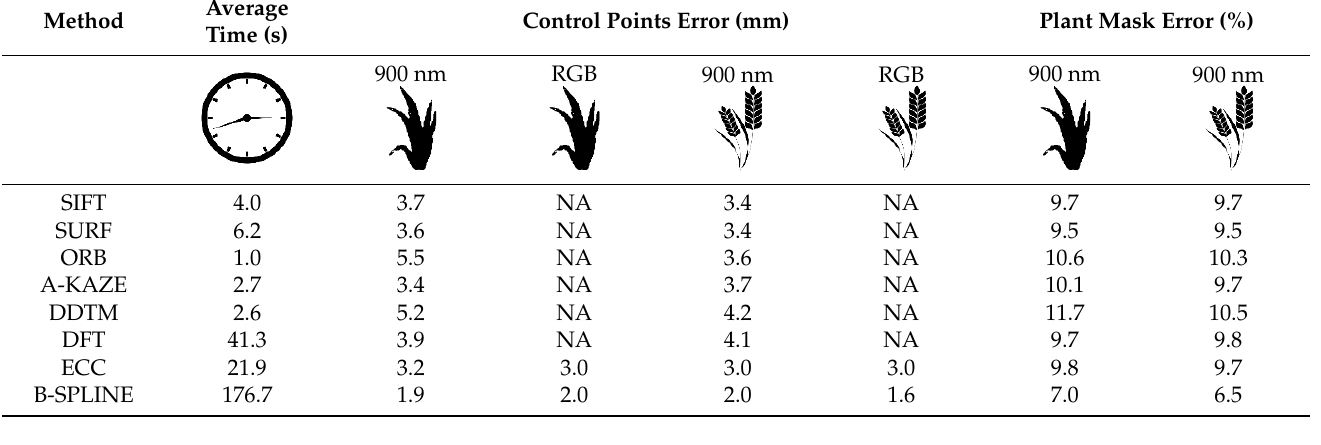
Table 2. Comparison of the registration methods based on three criteria: the average computation time to register one image of all cameras, the control points error and the plant mask error. Errors are averaged for dates before and after ears emergence. For the RGB images, some methods were discarded (NA values) because they did not yield a plausible alignment for all the test images.